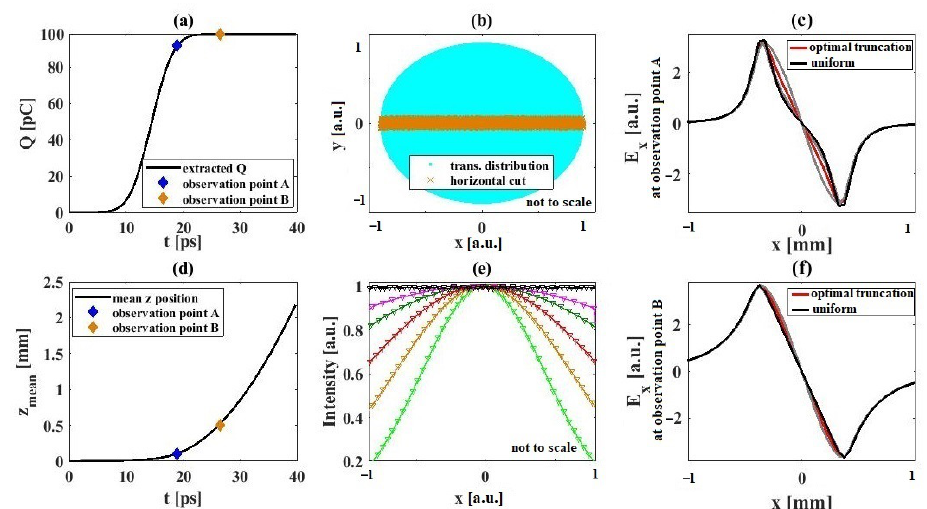
Figure 2. Optimization of a transverse Gaussian cathode drive laser distribution by adjusting the truncation ratio, i.e., a defined edge-to-center intensity ratio. ( a ) total extracted bunch charge versus emission time; ( b ) exemplary transverse cathode laser spot and its horizontal cut. Note that this is not to scale and only for illustration purpose; ( c ) computed transverse electric space-charge fields during emission at the observation point A as marked in ( a , d ); ( d ) mean bunch position versus emission time; ( e ) exemplary intensity projections of a horizontal cut to the transverse cathode laser spot as sketched in ( b ): different curves correspond to transverse cathode laser distributions with various edge-to-center (truncation) intensity ratios of 1 (uniform, black curve), 0.9 (pink), 0.8 (dark green), 0.6 (red), 0.4 (yellow) and 0.2 (light green), respectively. Note that subplots ( b , e ) are for illustration purpose and not to scale; ( f ) computed transverse electric space-charge fields at the end of emission at the observation point B as marked in ( a , d ).